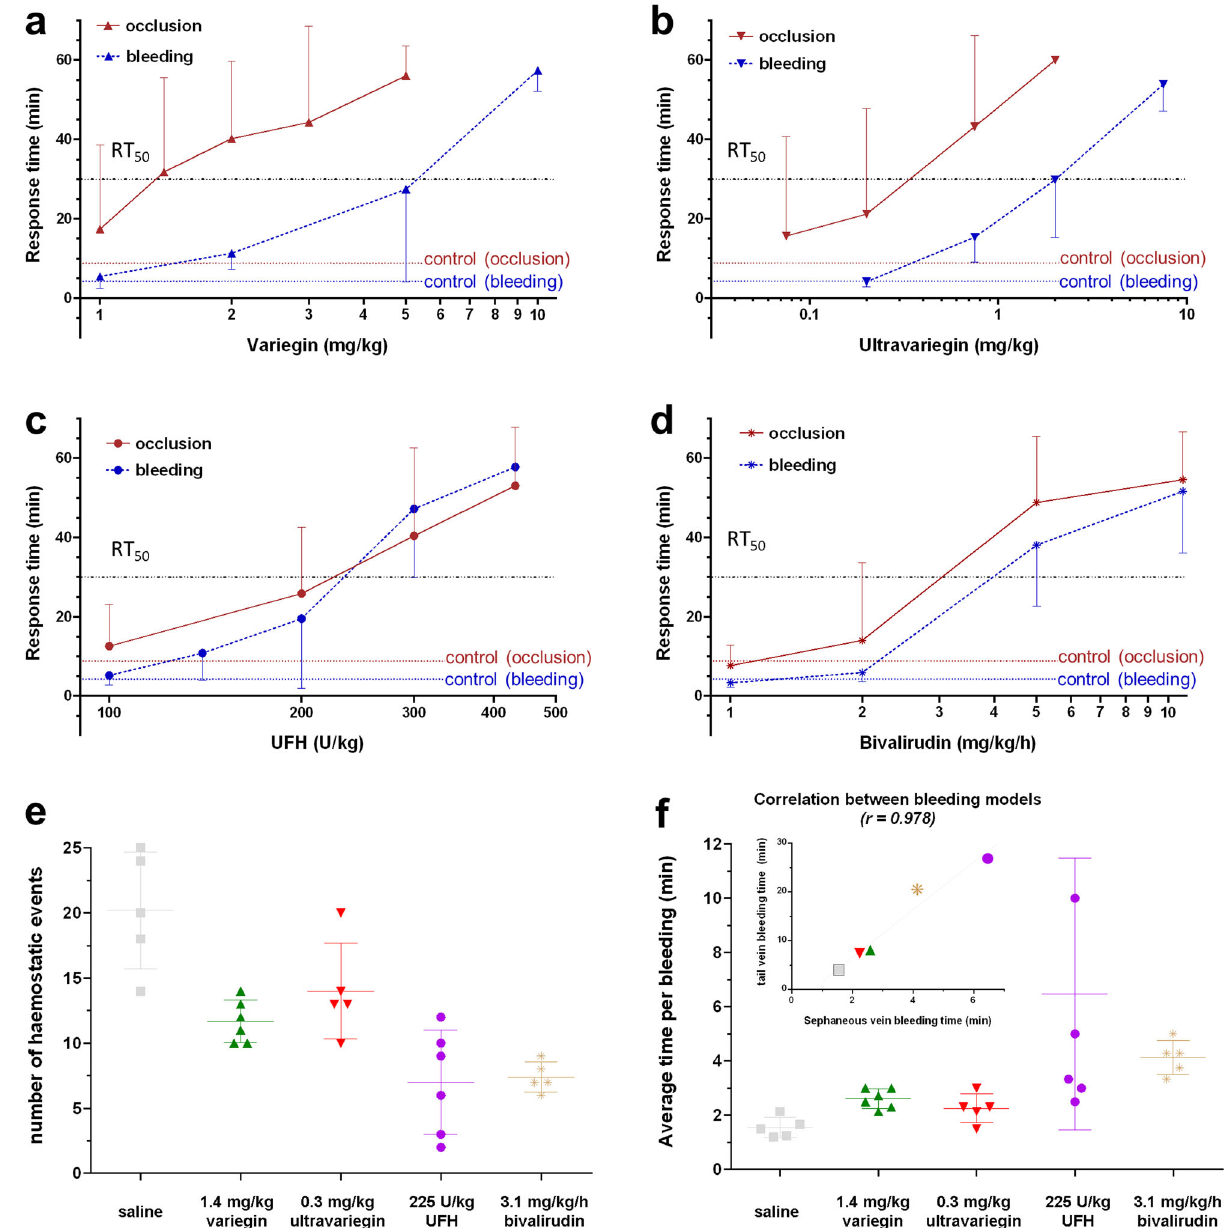
Fig. 4 Ef fi cacy-safety pro fi les of anticoagulants in rat models. Ef fi cacy and safety were determined using FeCl 3 -induced carotid artery thrombosis and tail incision bleeding models, respectively. The duration of observations ( y axis) for both models were standardised at 60 min and titled as Response Time. This facilitates the visualisation of the separation between ef fi cacy (occlusion, red) and safety (bleeding, blue) at any given dose of anticoagulants. Time taken for the carotid artery to be completely occluded (red) was plotted against increasing doses of ( a ) variegin at 1.0 ( n = 6), 1.4 ( n = 8), 2.0 ( n = 8), 3.0 ( n = 6), 5.0 ( n = 7) mg/kg; b ultravariegin at 0.075 ( n = 5), 0.2 ( n = 7), 0.75 ( n = 5), 2.0 ( n = 3) mg/kg; c UFH at 100 ( n = 5), 200 ( n = 5), 300 ( n = 6), 432 ( n = 8) U/kg and d bivalirudin at 1.0 ( n = 6), 2.0 ( n = 7), 5.0 ( n = 8), 10.8 ( n = 5) mg/kg/h. Time for occlusion in rats injected with saline (red dash line) was 8.82 ± 3.57 min ( n = 6). Time taken for bleeding to stop (blue), was plotted against increasing doses of ( a ) variegin at 1.0 ( n = 6), 2.0 ( n = 7), 5.0 ( n = 8), 10 ( n = 7) mg/kg; b ultravariegin at 0.2 ( n = 5), 0.75 ( n = 6), 2.0 ( n = 5), 7.5 ( n = 5) mg/kg; c UFH at 100 ( n = 5), 140 ( n = 6), 200 ( n = 8), 300 ( n = 7), 432 ( n = 5) U/kg; and d bivalirudin at 1.0 ( n = 6), 2.0 ( n = 7), 5.0 ( n = 7), 10.8 ( n = 6) mg/kg/h. Time for bleeding in rats injected with saline (blue dash line) was 4.25 ± 1.67 min ( n = 5). Doses of respective anticoagulants to elicit 50% of response in the models (RT 50 , dotted lines) were estimated and used to calculate the therapeutic index (TI) as listed in Supplementary Table 3. e The number of haemostatic events (i.e., clot formation) and f average time per bleeding event (i.e., bleeding time) within 30 min in the saphenous vein bleeding model were used to validate results from tail incision bleeding model at doses in which ef fi cacy for respective treatments are at 50% (ie RT 50 for occlusion): saline control ( n = 5), 1.4 mg/kg variegin ( n = 6), 0.3 mg/kg ultravariegin ( n = 5), 225 U/kg UFH ( n = 6), 3.1 mg/kg/h bivalirudin ( n = 5). Figure insert shows correlation coef fi cient r = 0.978 ( p = 0.004) between bleeding time obtained from tail incision model ( y axis) and sapheneous vein bleeding model ( x axis). Data shown are mean ± SD.